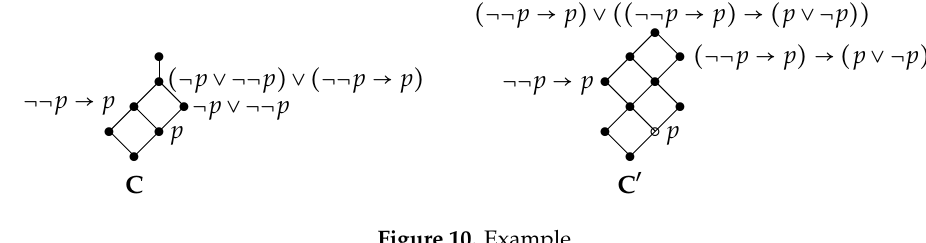
Figure 10. Example.